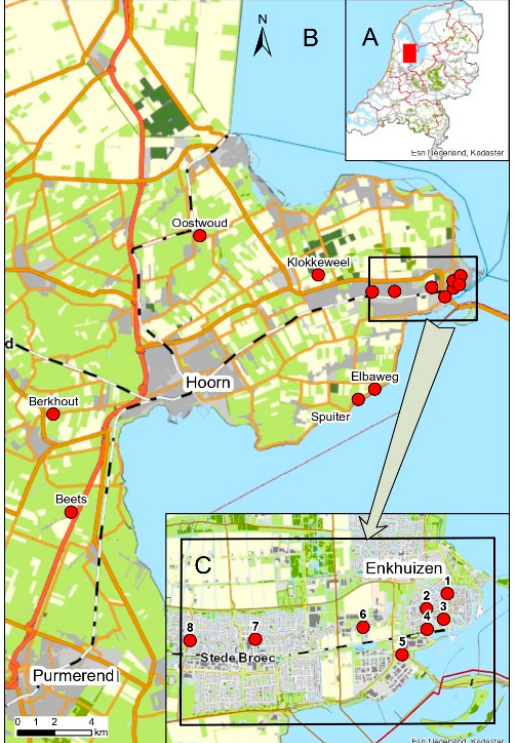
Figure 1. ( A ) Map of the Netherlands; and position of map ( B ) that shows the area where samples were taken. Sampling sites are indicated with red dots. Green: meadows; dark green: forested; yellow: arable; grey: villages and towns. ( C ) Detailed map of the Enkhuizen area showing position of sampling sites: 1: Vijzeltuin (EVT); 2: Raamstraat (ERS); 3: Paktuinen (EPK); 4: Lange Tuinstraat (ELT); 5: Enkhuizen-dijk [17]; 6: Westeinde (EWE); 7: Bovenkarspel (BVK); 8: Grootebroek-Zesstedenweg